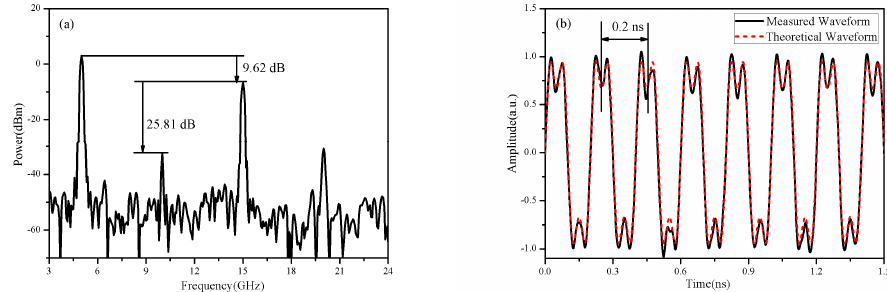
Figure 3. Measured ( a ) electrical power spectrum and ( b ) waveforms of the generated square waveform with a repetition rate of 5 GHz.